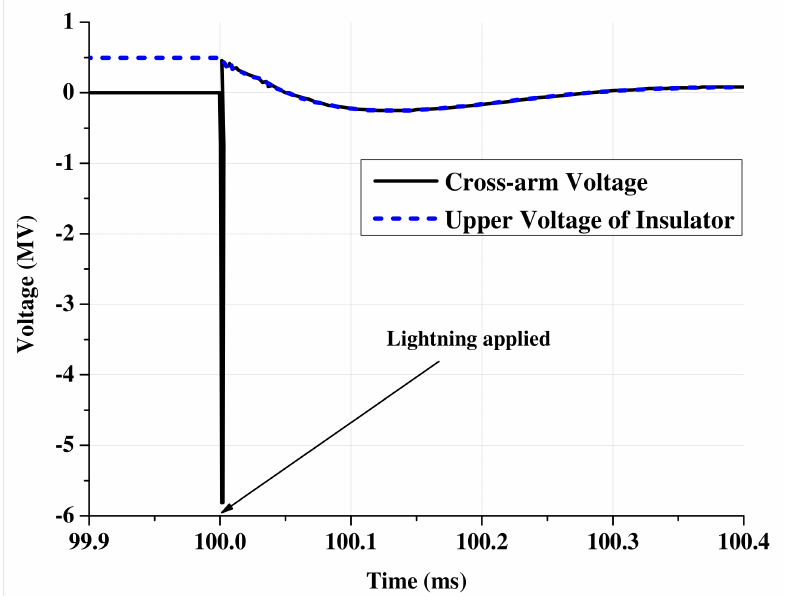
Figure 15. Voltage at tower cross-arm point and upper point of insulator with 190 kA lightning current.